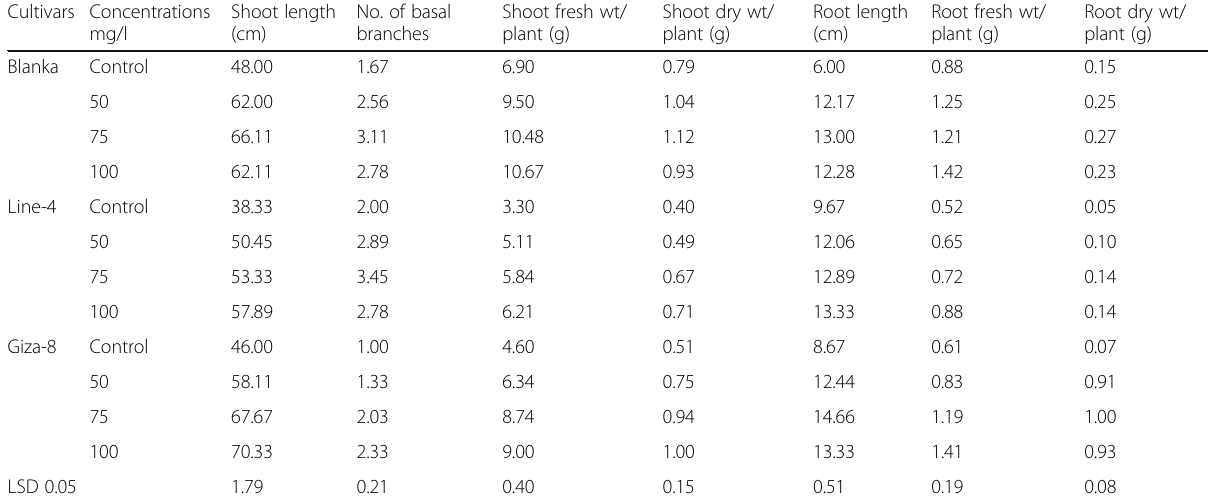
Table 14 Effect of cultivars and phenolic acid concentrations on growth parameters of flax plants grown under sandy soil conditions (data are means of two successive seasons) Cultivars Concentrations mg/l